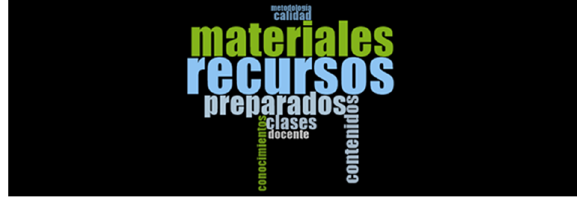
Fig. 3 Reasons for teaching quality evaluation. Tag Cloud. From: Data obtained from question no. 10b of the survey (open type). Tag cloud. Compiled by the authors based on the information provided by the software Nvivo. The translation of the words from Spanish to English in descending order from highest to lowest is: resources prepared/materials/classes/ teacher/content/quality/knowledge.